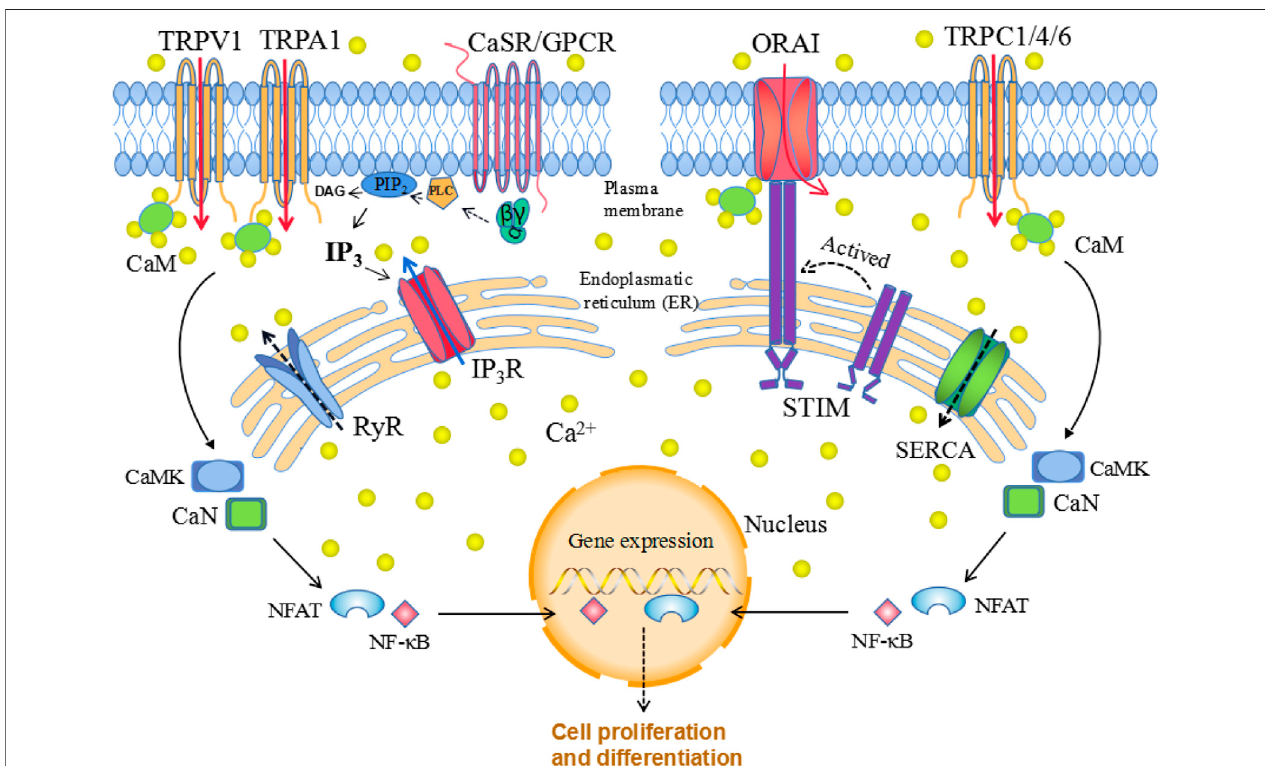
FIGURE 1 | Cellular calcium homeostasis. The calcium-sensing receptor (CaSR), which is a G protein-coupled receptor (GPCR), senses changes in extracellular calcium concentrations, leading to phospholipase C (PLC) activation; activated PLC then hydrolyzes phosphatidylinositol-4,5-bisphosphate (PIP 2 ), generating inositol 1,4,5-trisphosphate (IP 3 ) and diacylglycerol (DAG). The binding of IP 3 to the IP 3 receptor (IP 3 R) located in the ER allows Ca 2+ release from the ER. When the ER Ca 2+ stores are depleted, this is sensed by STIM family proteins localized in the ER membrane, which translocate to the plasma membrane and interact with ORAI, thereby triggering selective store-operated Ca 2+ entry (SOCE). Similarly, release of Ca 2+ through ryanodine receptors (RyRs) is pumped back into the endoplasmic reticulum calcium through ATPase (SERCA). Elevated [Ca 2+ ]i regulate gene expression via Ca 2+ /CaM pathway. The main downstream targets: Ca 2+ /CaM-kinases (CaMK) and calcineurin (CaN), could regulate transcription factors such as NFAT and NF κ B, to in fl uence cell function ( Figure 1